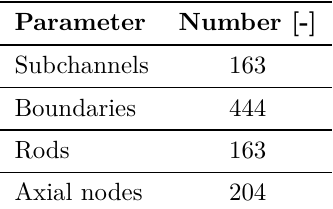
Table 1. Core subchannel model.